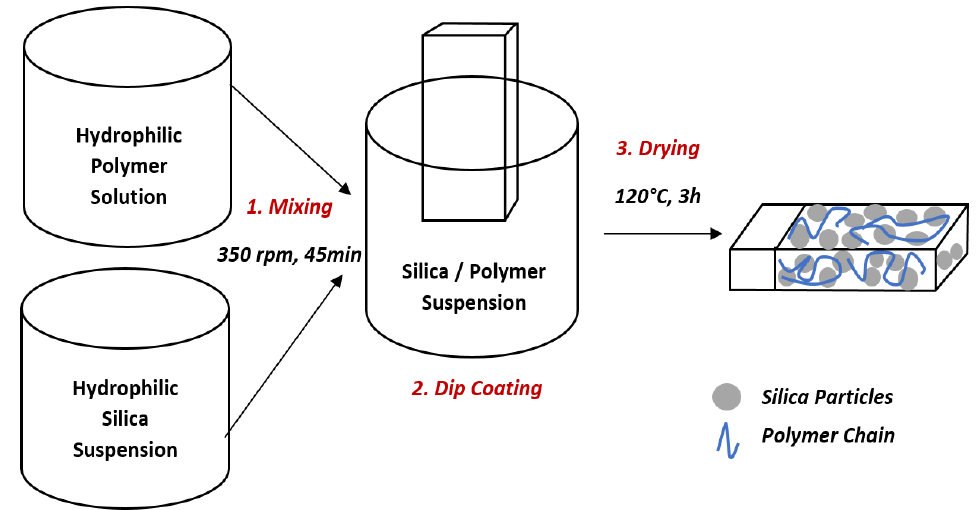
Figure 1. Superhydrophilic coating fabrication process.